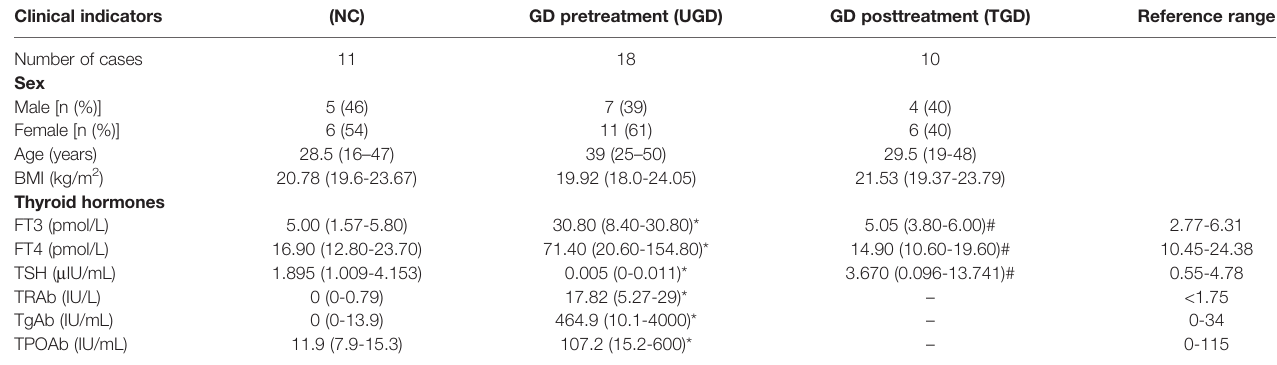
TABLE 1 | The basic clinical features of the three